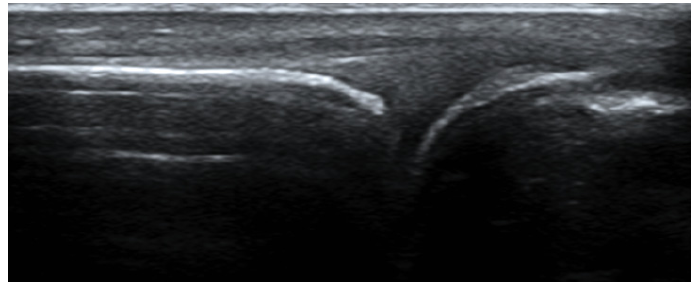
Figure 5. Example of a typical ultrasound image of a wrist used in the database of [15].